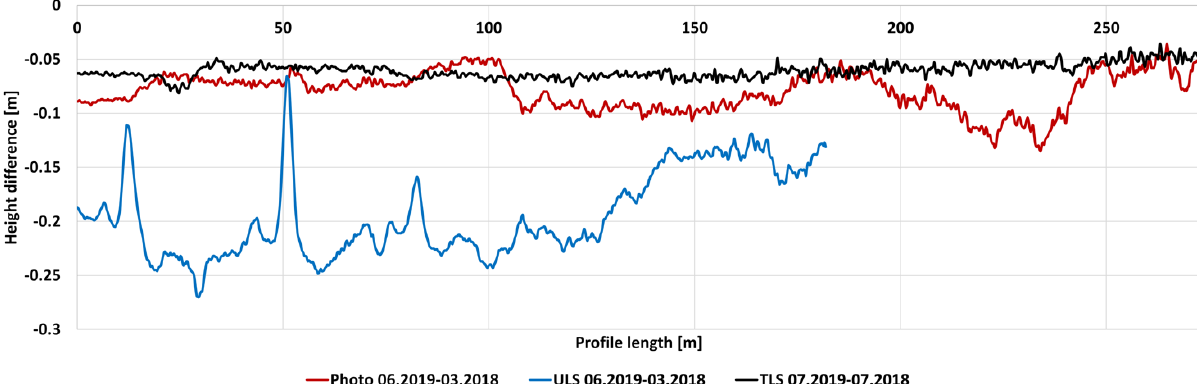
Figure 12 . Example cross-sections of differential models created for the same data type for the main road crossing the scene